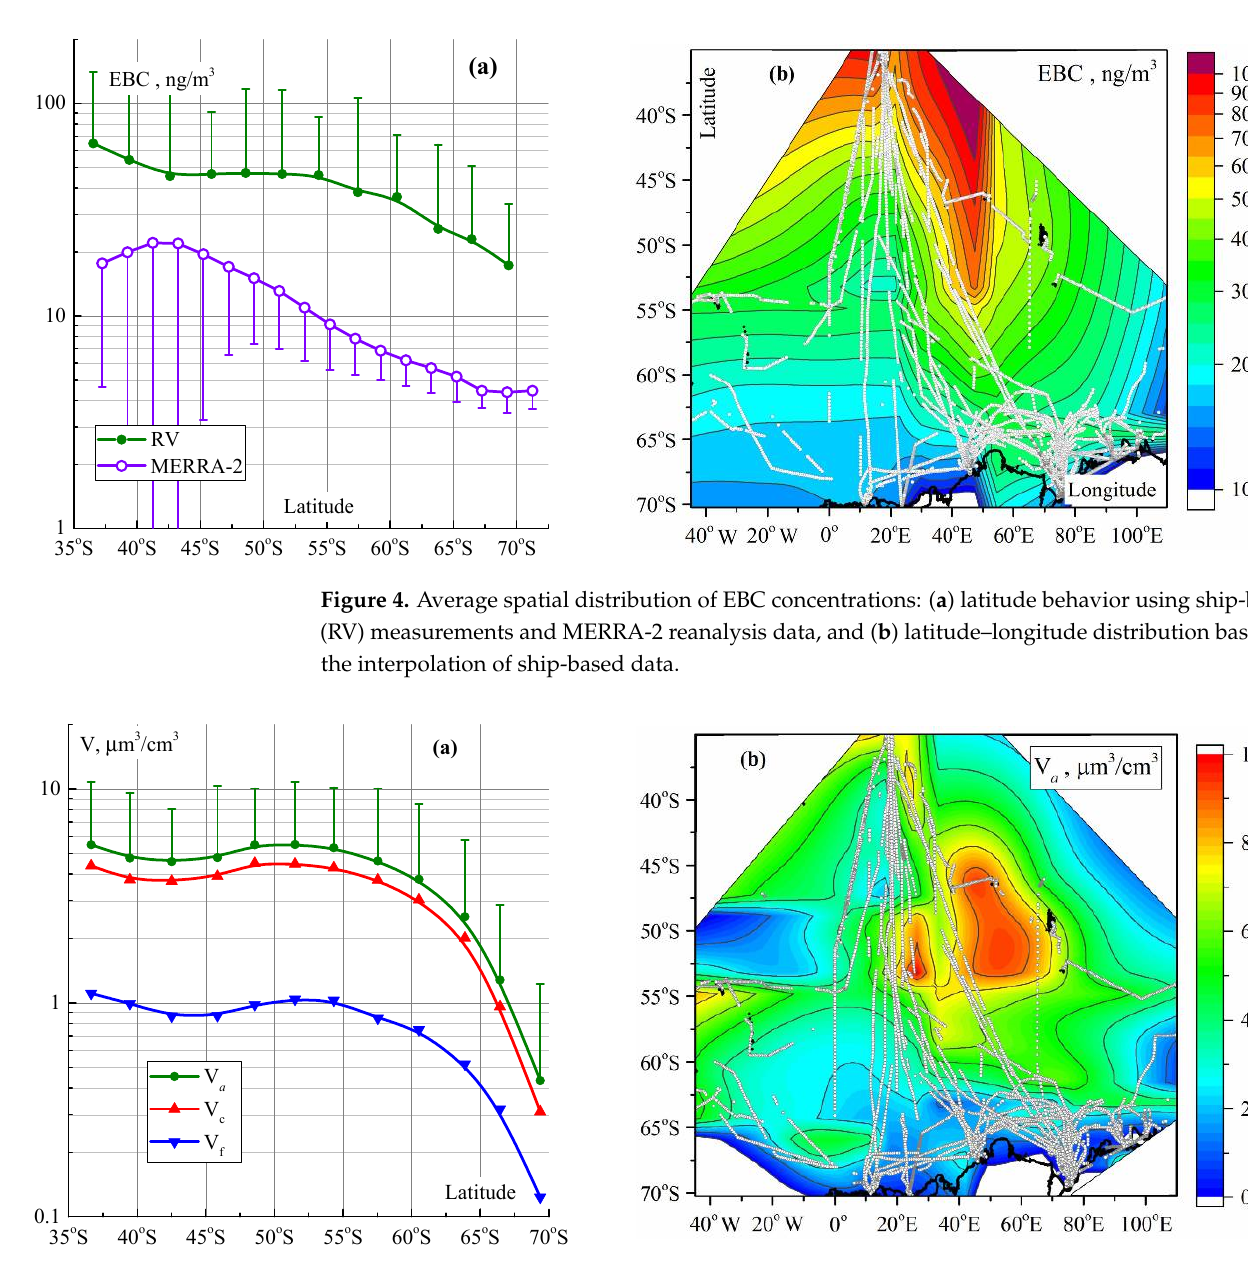
Figure 3. Average spatial distribution of the atmospheric AOD: ( а ) latitude behavior using ship- based (RV) measurements and MERRA-2 reanalysis data, and ( b ) latitude–longitude distribution based on the interpolation of ship-based data (dashed line indicates the Southern Ocean border).